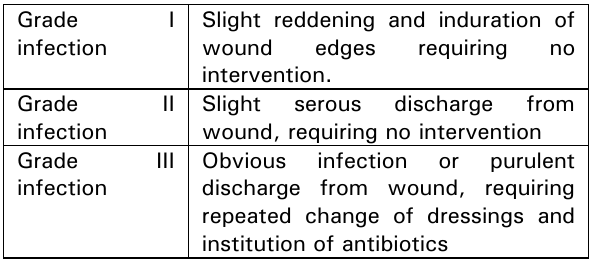
Table 1: Grades of Wound